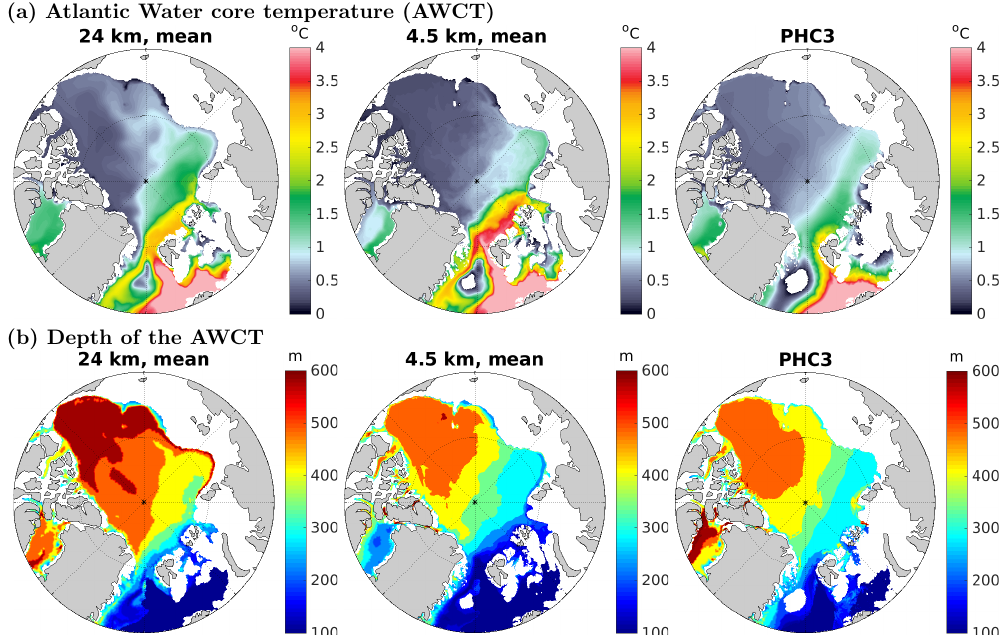
Figure 4. (a) Atlantic Water core temperature (AWCT) for (from left to right) simulations LOW and HIGH and the PHC climatology. (b) The same as panel (a) but for the depth of AWCT. Shelf regions ( < 200m) are not shown. The model results are averaged from 1970 to 1999 for the purpose of comparison to the PHC